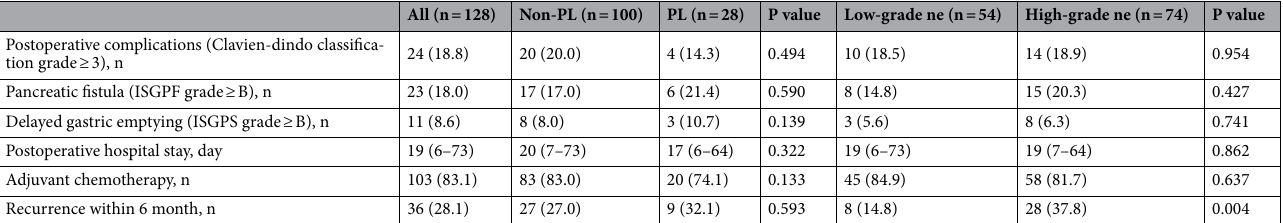
Table 3. Postoperative outcomes in the entire cohort. ISGPF the International Study Group of Pancreatic Fistula, ISGPS the International Study Group of Pancreatic Surgery, ne nerve invasion, PL extrapancreatic nerve plexus invasion.